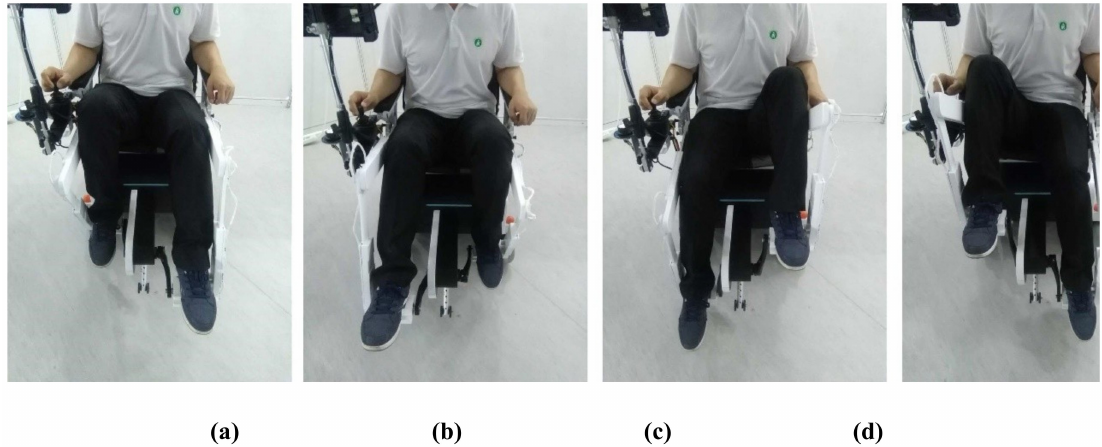
Figure 6. Still images from feasibility experiment during one complete cycle of the crank in different positions: ( a ) Top dead center; ( b ) Power phase; ( c ) Bottom dead center; ( d ) Recovery phase.